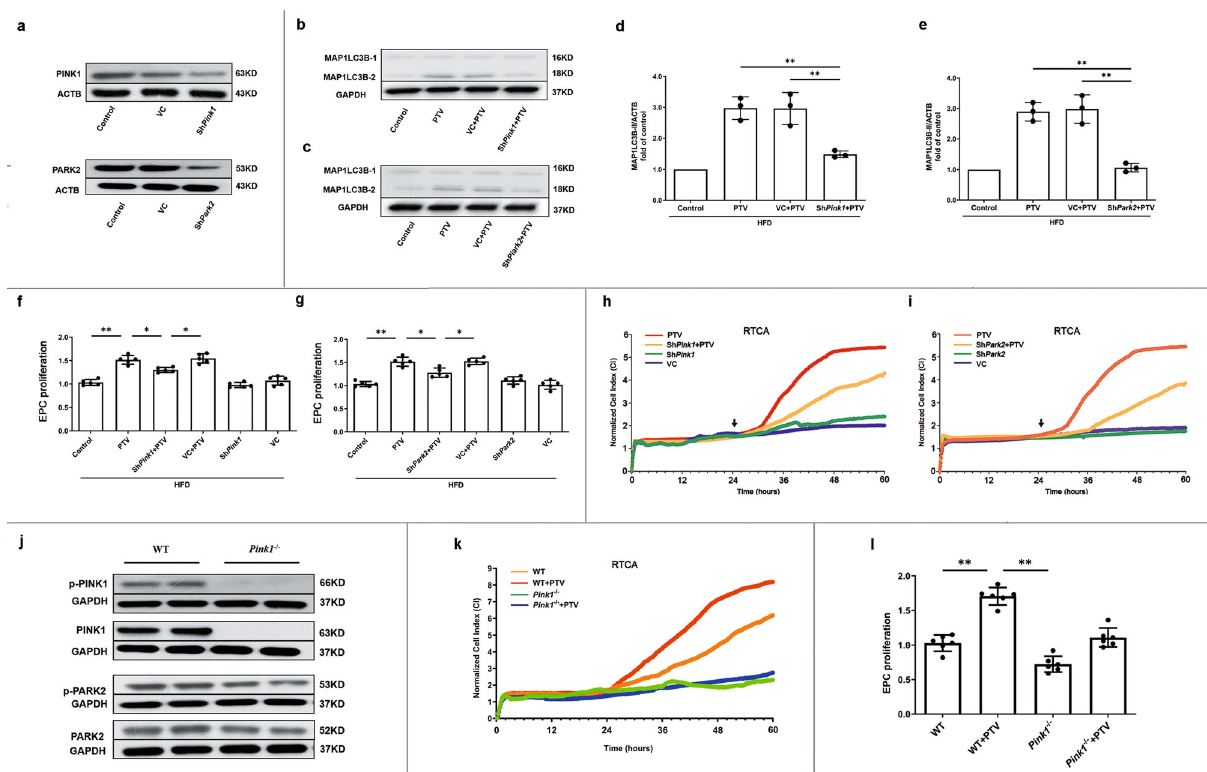
Fig. 5 PINK1-PARK2 pathway contributed to EPC proliferation. a Representative western blots showed that shRNA targeting Pink1 (sh Pink1 ) effectively silenced PINK1 protein expression and shRNA targeting Park2 (sh Park2 ) effectively silenced PARK2 protein expression after 24h infection, respectively. Representative western blots and quantitative analysis revealed that either silencing Pink1 ( b , d ) or Park2 ( c , e ) signi fi cantly reduced MAP1LC3B expression. CCK-8 assay showed that either silencing Pink1 ( f ) or Park2 ( g ) before PTV treatment signi fi cantly reduced proliferative activity compared with PTV alone group. h EPCs of silencing Pink1 were seeded on E-plates for 24 h, 0.5 μ M PTV was added to E-plates in PTV and sh Pink1 + PTV groups after 24 h incubation (black arrow). The normalized cell index indicated that EPC proliferative activity decreased in sh Pink1 + PTV group compared with PTV alone group. i EPCs of silencing Park2 were seeded on E-plates for 24 h, 0.5 μ M PTV was added to E-plates in PTV and sh Park2 + PTV groups after 24 h incubation (black arrow). The normalized cell index indicated that EPC proliferative activity decreased in sh Park2 + PTV group compared with PTV alone group. j Western blots of the expression of PINK1, PARK2 and their phosphorylated form in WT and Pink1 − / − mice. EPCs with or without 0.5 μ M PTV treatment were seeded on E-plates for 24 h, 0.5 μ M in PTV and Pink1 − / − + PTV groups after 24 h incubation. The normalized cell index ( k ) and CCK-8 ( l ) indicated that EPC proliferative activity fell down in WT and Pink1 − / − mice with or without PTV treatment. (EPCs were isolated from ApoE − / − mice fed with high-fat diet for 8 weeks, cells were isolated from 3 mice for 1 experiment and 3 independent experiments were performed, mean ± SD, * P < 0.05, ** P <